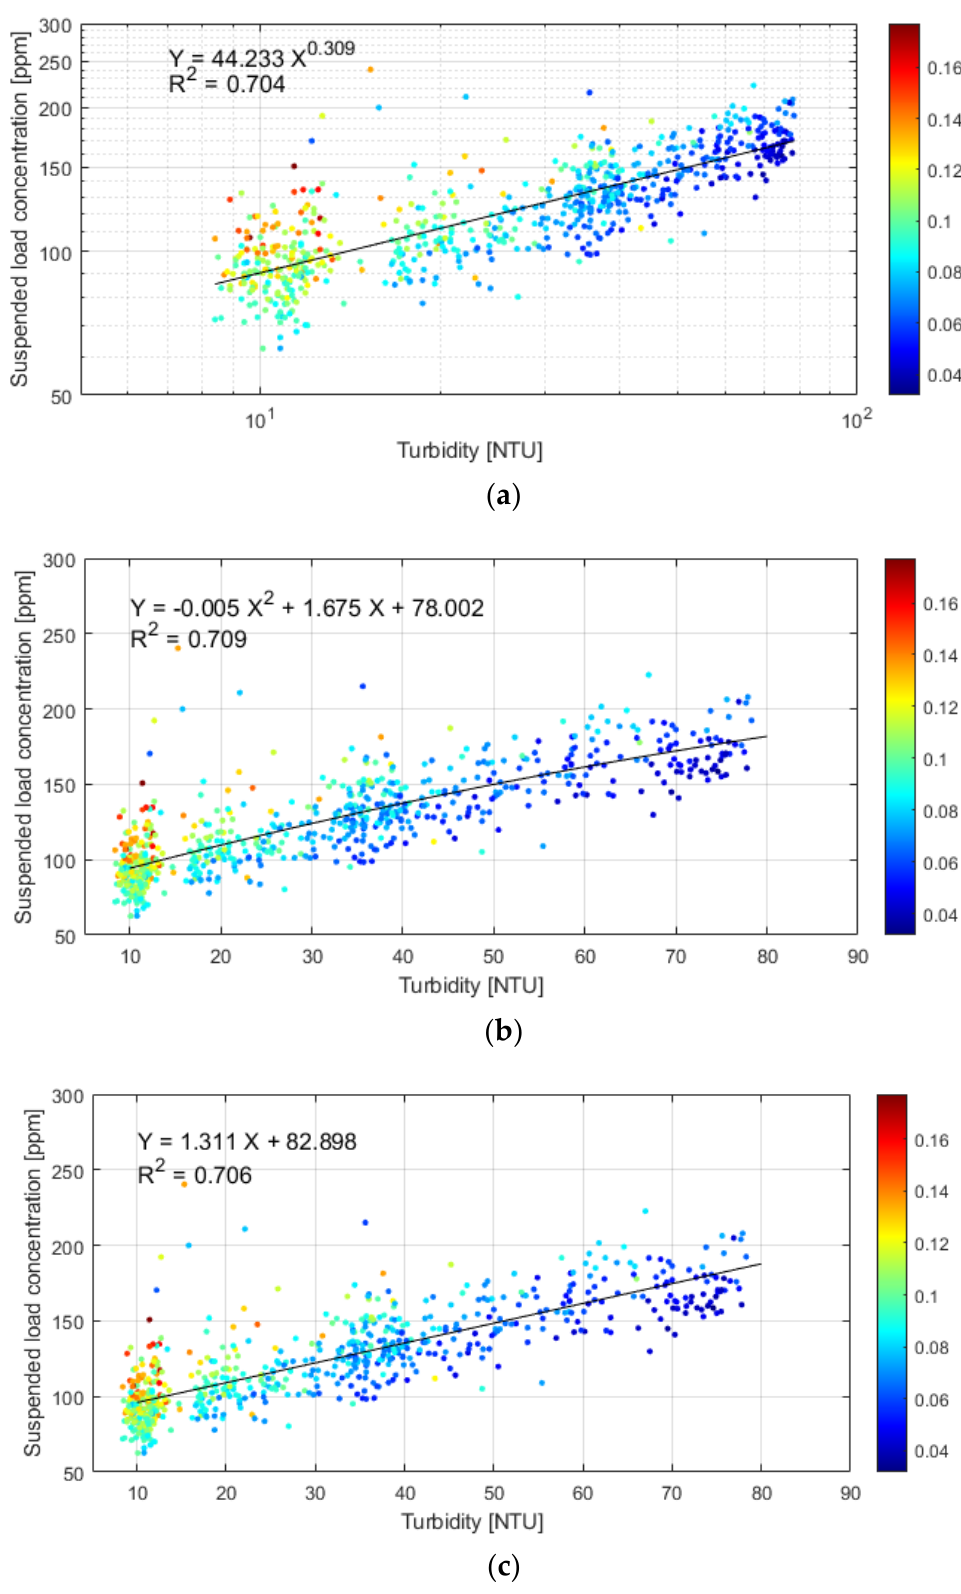
Figure 12. Turbidity-concentration relationships based on average suspended sediment particle size ( a ) power-law, ( b ) second-order polynomial, and ( c ) first-order polynomial. The proposed turbidity-concentration relationships showed similar R 2 values. Con-